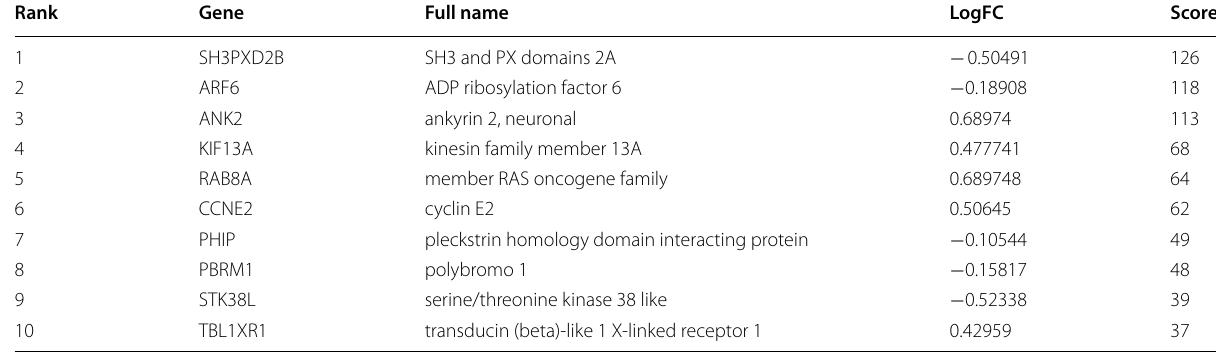
Table 2 Basic information of top 10 hub genes